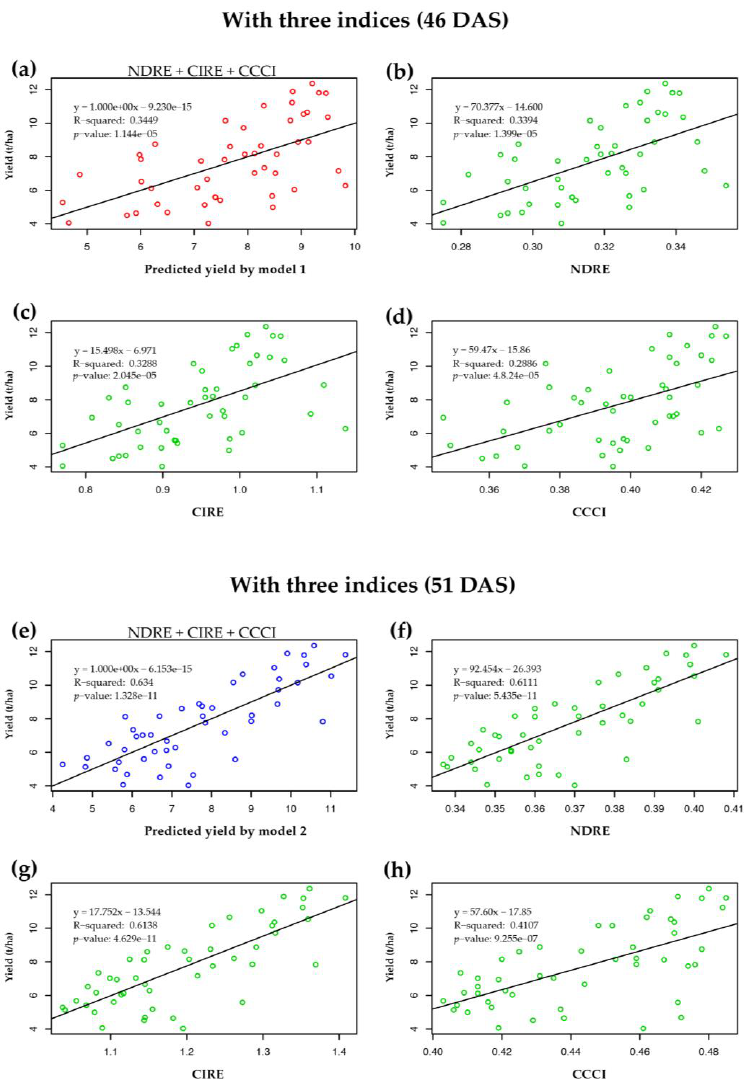
Figure 6. Maize yield prediction models with multiple linear regression: ( a ) Model 1 for performance prediction using the NDRE, CIRE and CCCI indices at 46 DAS; ( b ) Model 1 for performance prediction using NDRE at 46 DAS; ( c ) Model 1 for performance prediction using CIRE at 46 DAS; ( d ) Model 1 for performance prediction using CCCI at 46 DAS; ( e ) Model 2 for performance prediction using the GCI, NDRE and CIRE indices at 51 DAS; ( f ) Model 2 for performance prediction using GCI at 51 DAS; ( g ) Model 2 for performance prediction using NDRE at 51 DAS; ( h ) Model 2 for performance prediction using CIRE at 51 DAS.